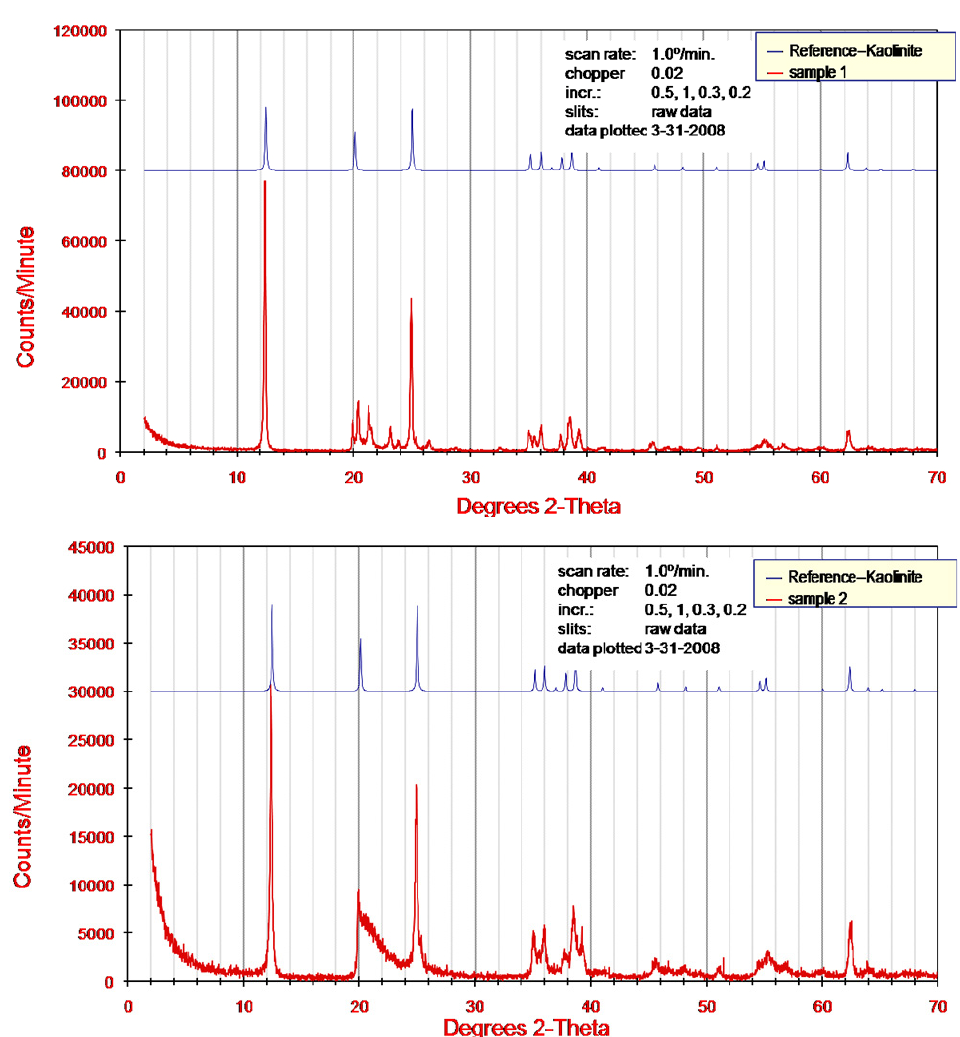
Figure 2. XRD spectra for kaolinite (top) and Kaofine (bottom). Reference is in